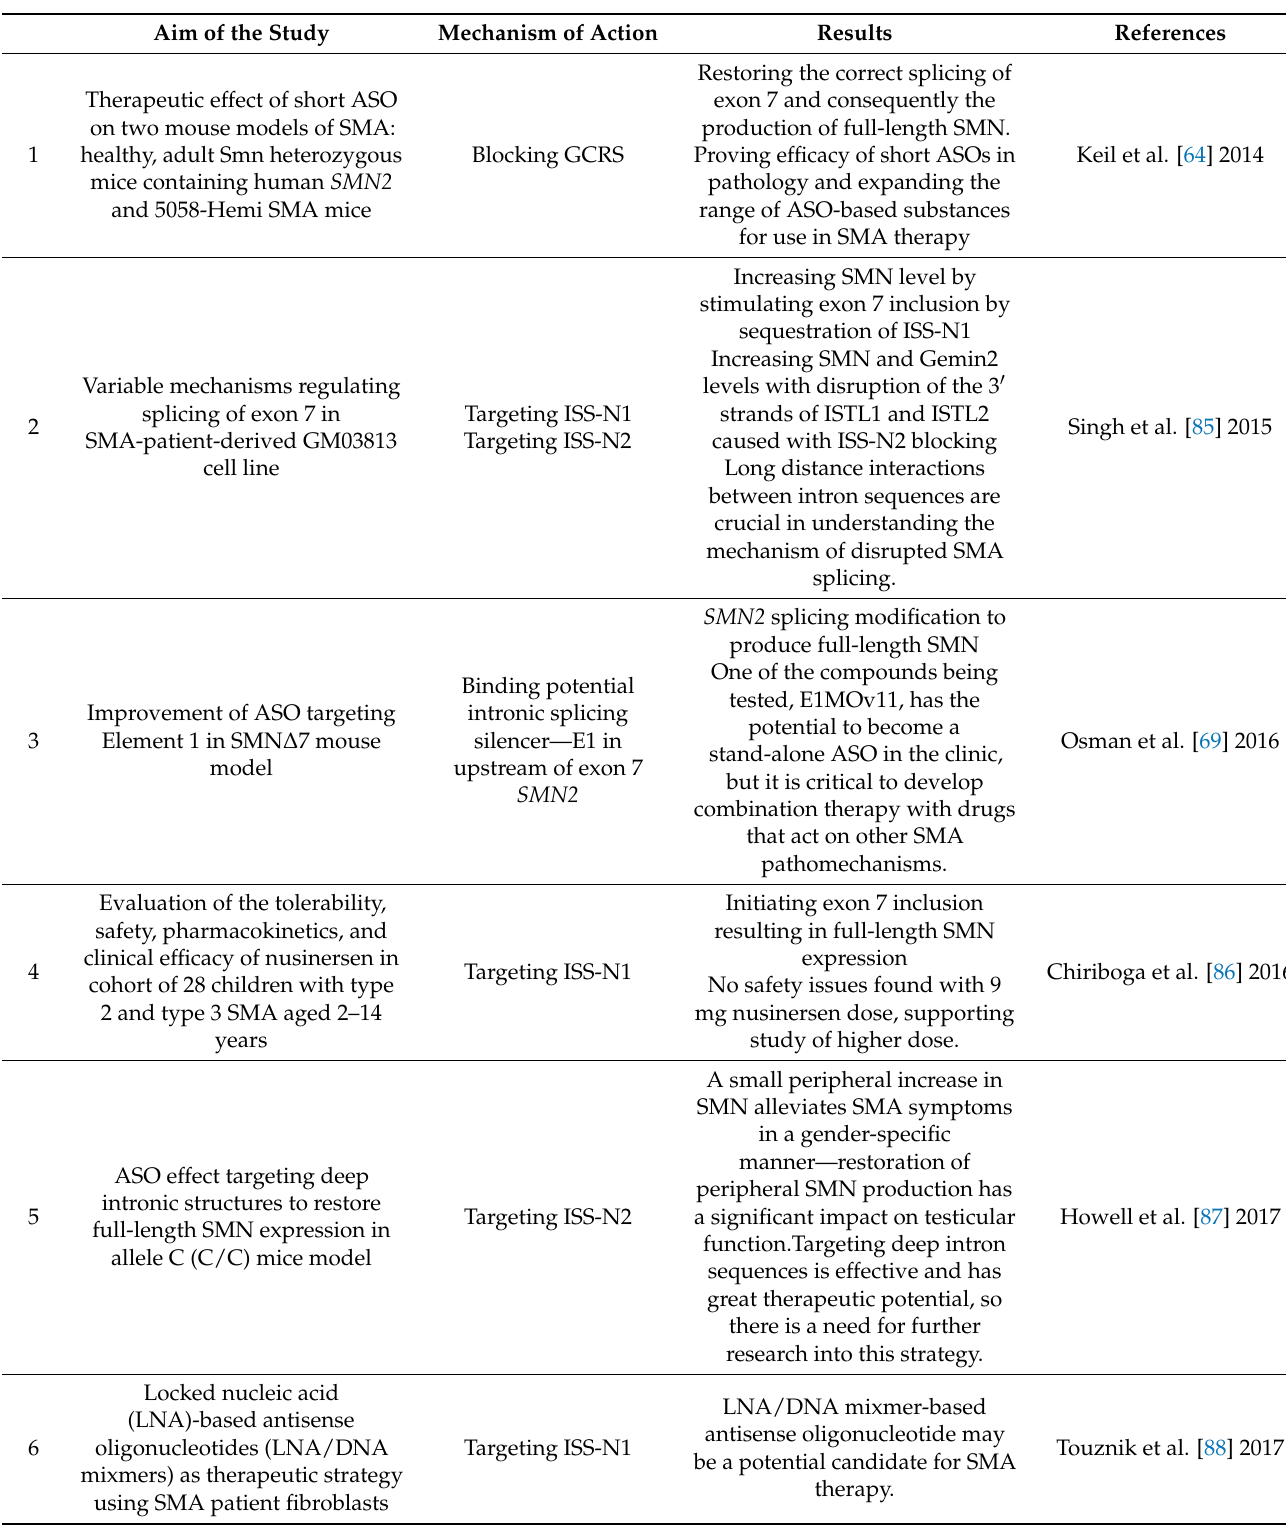
Table 1. Comparison of potential and the newest targets for ASOs in SMA